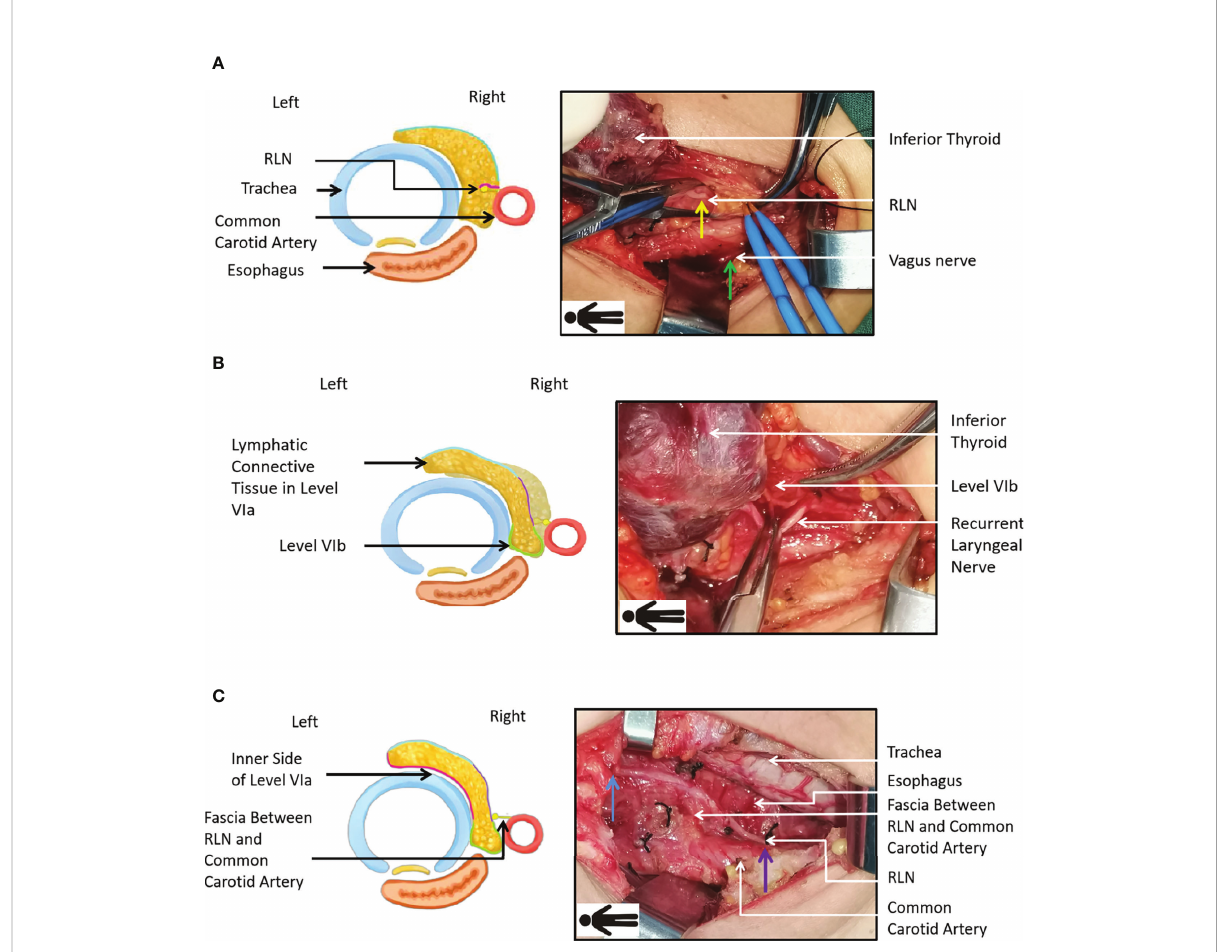
FIGURE 2 Technique of Fang ’ s capillary fascia preservation right recurrent laryngeal nerve (F-R-RLN) dissection. (A) Dissecting super fi cial lymph connective tissue of RLN and cutting the lateral border of level VIa (the purple line in the fi gure). The green arrow points to the V1 electrical signal monitor point from the vagus nerve and the yellow arrow points to the R1 electric signal monitor point from the RLN. (B) Sparing RLN laterally to the superior and inner side of the common carotid artery and dissecting level VIb lymph connective tissue (the green line in the fi gure). (C) Preserving the capillary network encased by the fascia between the RLN and the common carotid artery and dissecting level VI lymph connective tissue (the red line in the fi gure). The blue arrow points to the R2d in the upper laryngeal inlet part. The purple arrow points to the R2p in the lower neck part. Laryngeal body is dislocated to the left and upper side in order to expose level VIb and therefore the esophagus is shifted to the right side of the trachea.